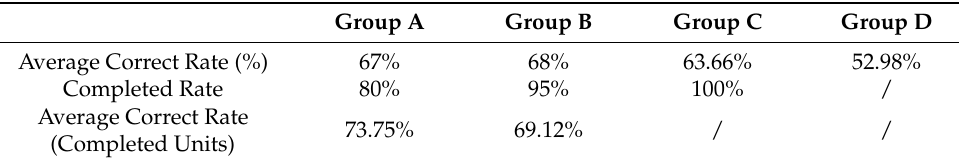
Table 5. Experiment Data.